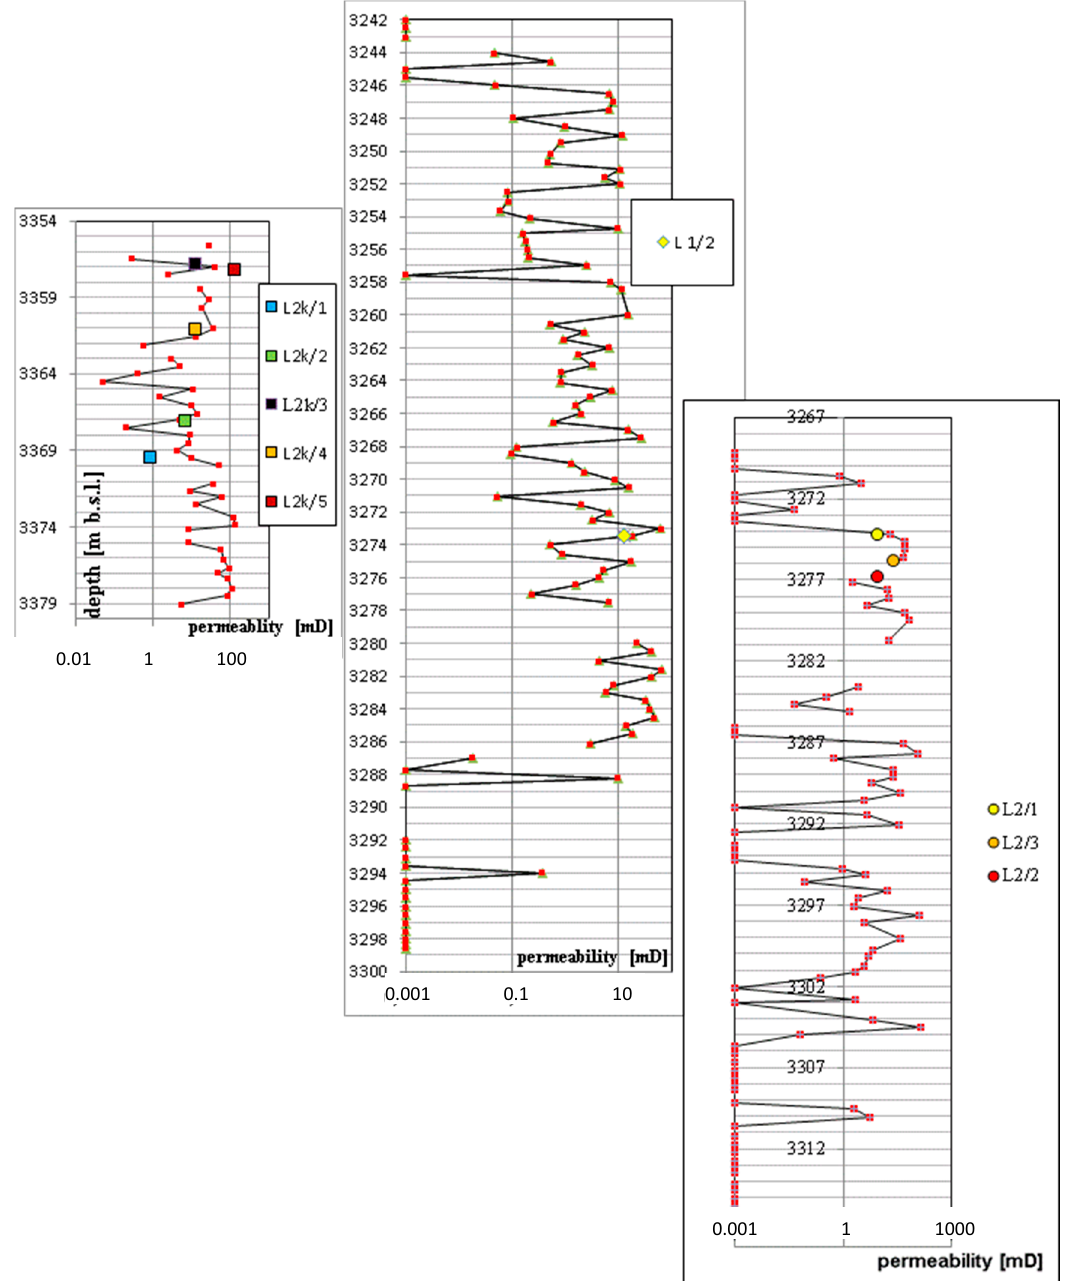
Figure 5. Permeability of dolomites from the Well 2k (L2k), Well 1 (L1) and Well 2 (L2) wells ([24,25,90] and this work).